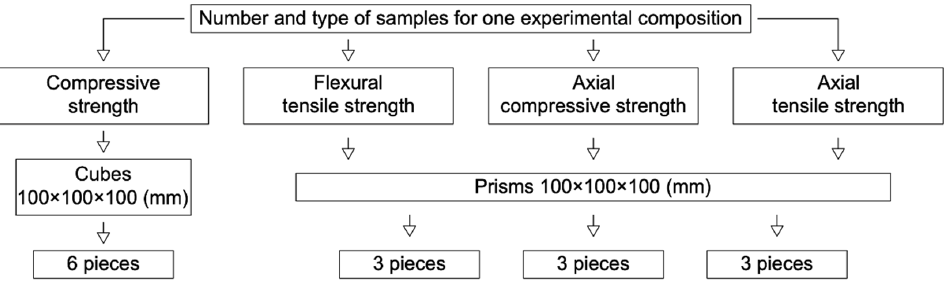
Figure 3. Program of the experiment.